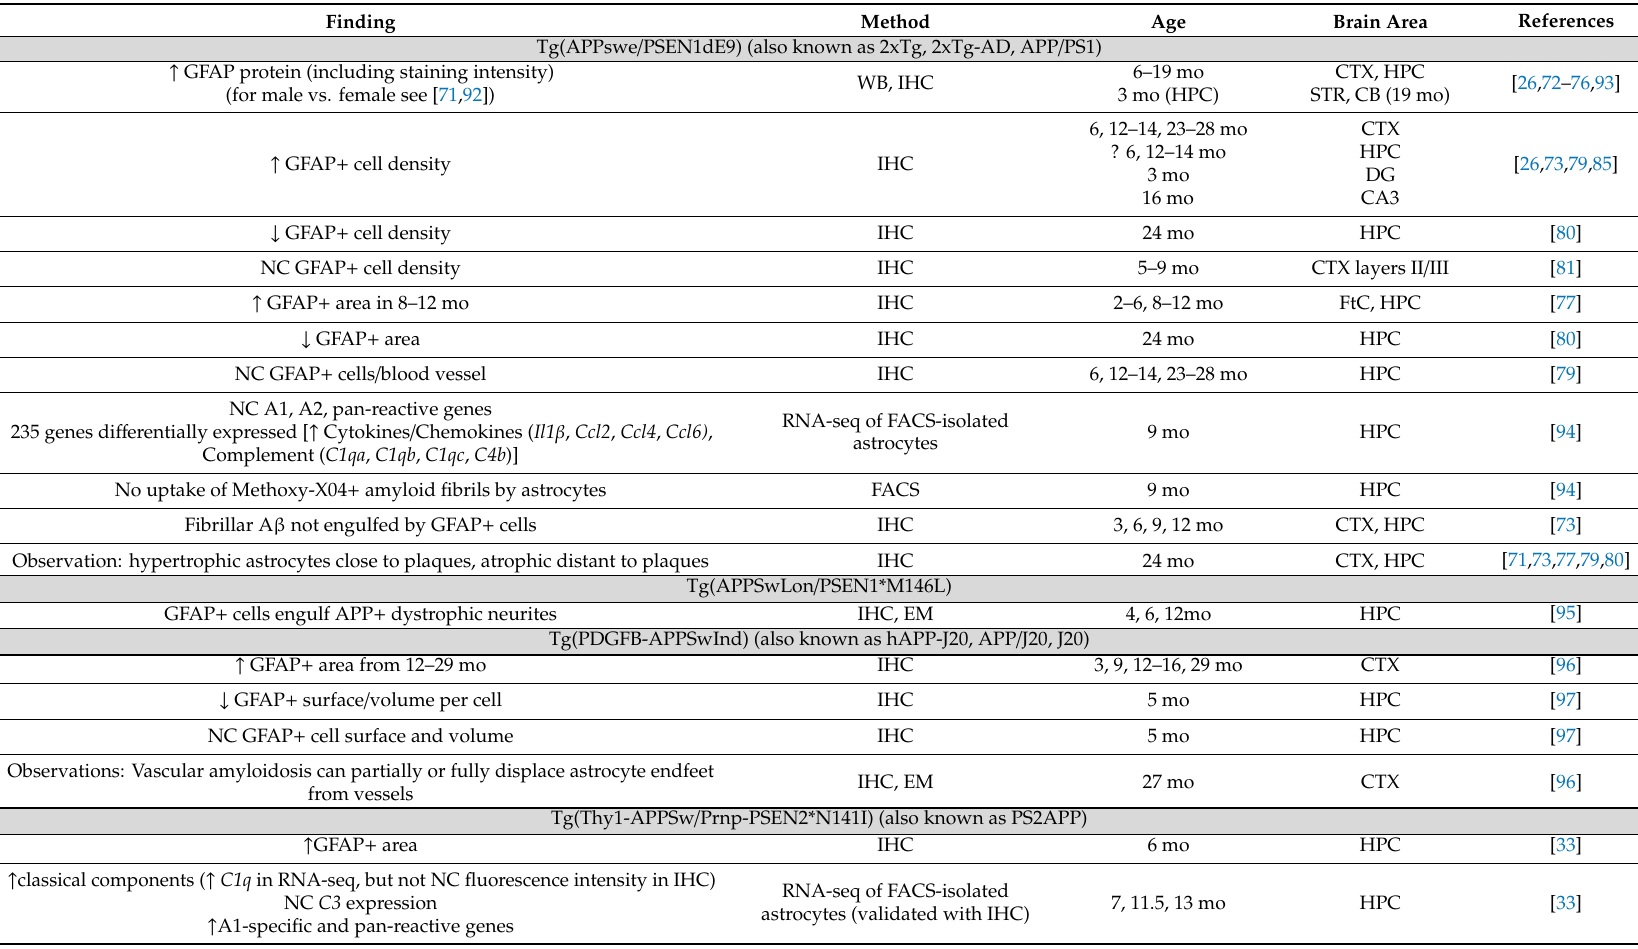
Table 1. Reported changes in the GFAP, AQP4, complement pathway, and cytokines in astrocytes from APP or PSEN mouse models. All comparisons are versus age-matched, wild-type mice, unless otherwise mentioned. For more information on the genetic background models see Table 2. For a full overview in APP and / or PSEN mouse models see Supplementary Table S1. For an overview of astrocyte responses in Tau mouse models see Supplementary Table